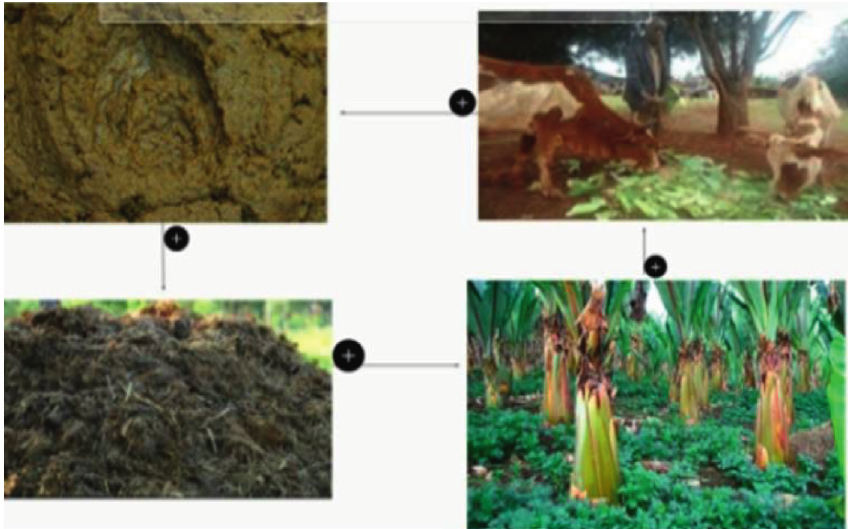
Figure 5: Enset tree nexus with livestock; source: authors own